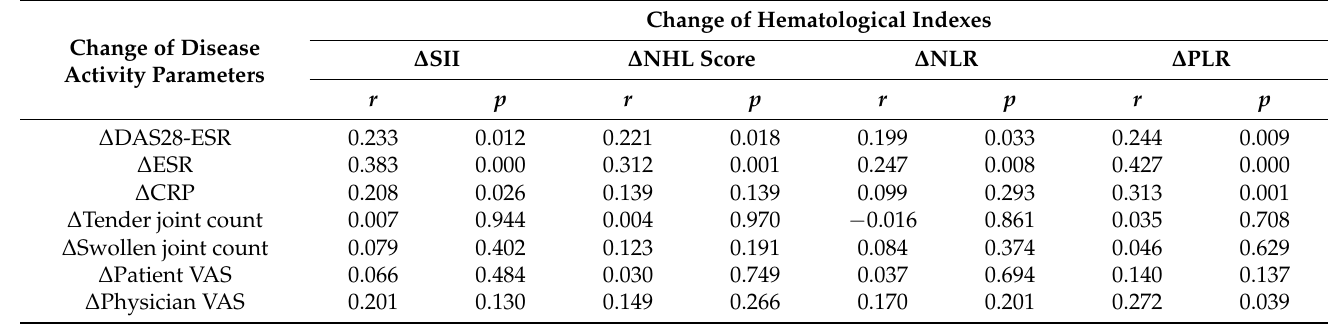
Table 3. Correlation between changes in hematological indexes and disease activity parameters in rheumatoid arthritis ( n = 115).